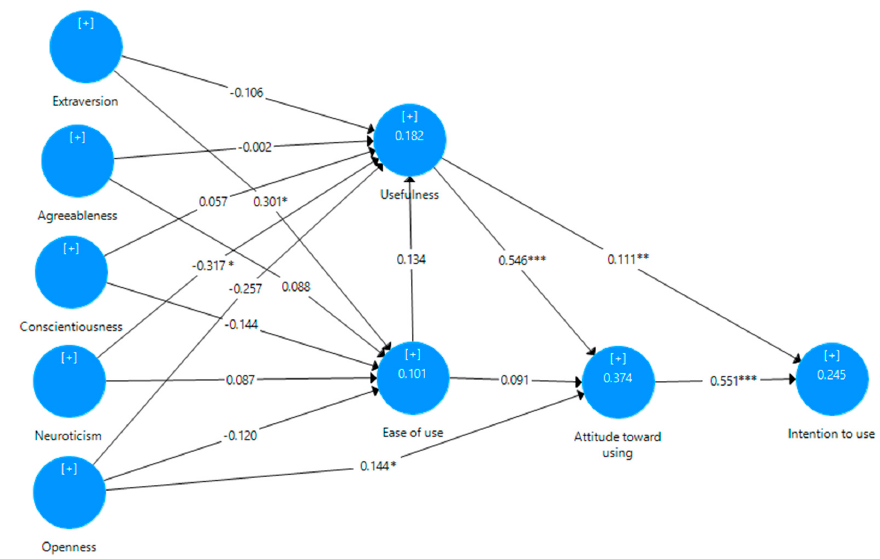
Figure 5. Structural model results. * p <0.05; ** p < 0.01; *** p < 0.001.